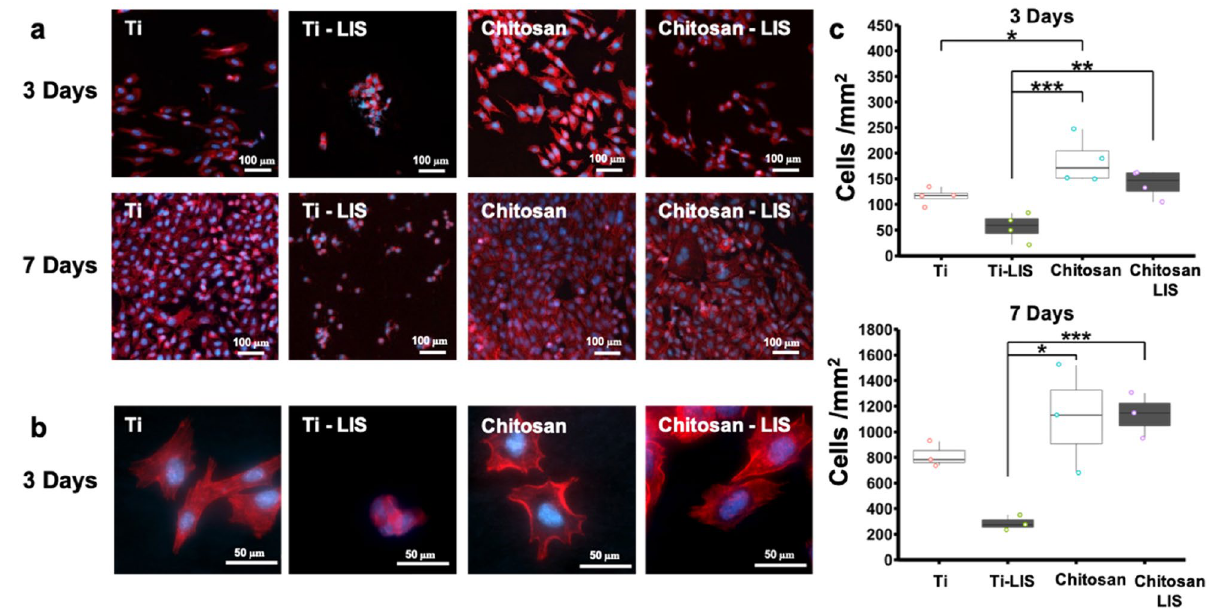
Figure 3. SaOS-2 Cell Proliferation After Three- and Seven-day Cell Cultures. ( a ) Representative fluorescence microscopy images (nuclei: blue; microfilaments: red) displaying the density and distribution of adherent cells on titanium and titanium treated surfaces. ( b ) Representative fluorescence microscopy images (nuclei: blue; microfilaments: red) displaying the morphology of the cells on titanium and titanium coated surfaces. ( c ) Number of adherent cells on control and treated titanium surfaces after three- and seven-day cell cultures. Error bars represent the standard deviation. n = 4 for all groups in the 3-day study and n = 3 for all groups in the 7-day study. Statistical analysis was performed using a one-way ANOVA followed by a Tukey test. Significance annotation is shown as ‘*’ for P < 0.05, ‘**’ for P < 0.01 and ‘***’ for P <